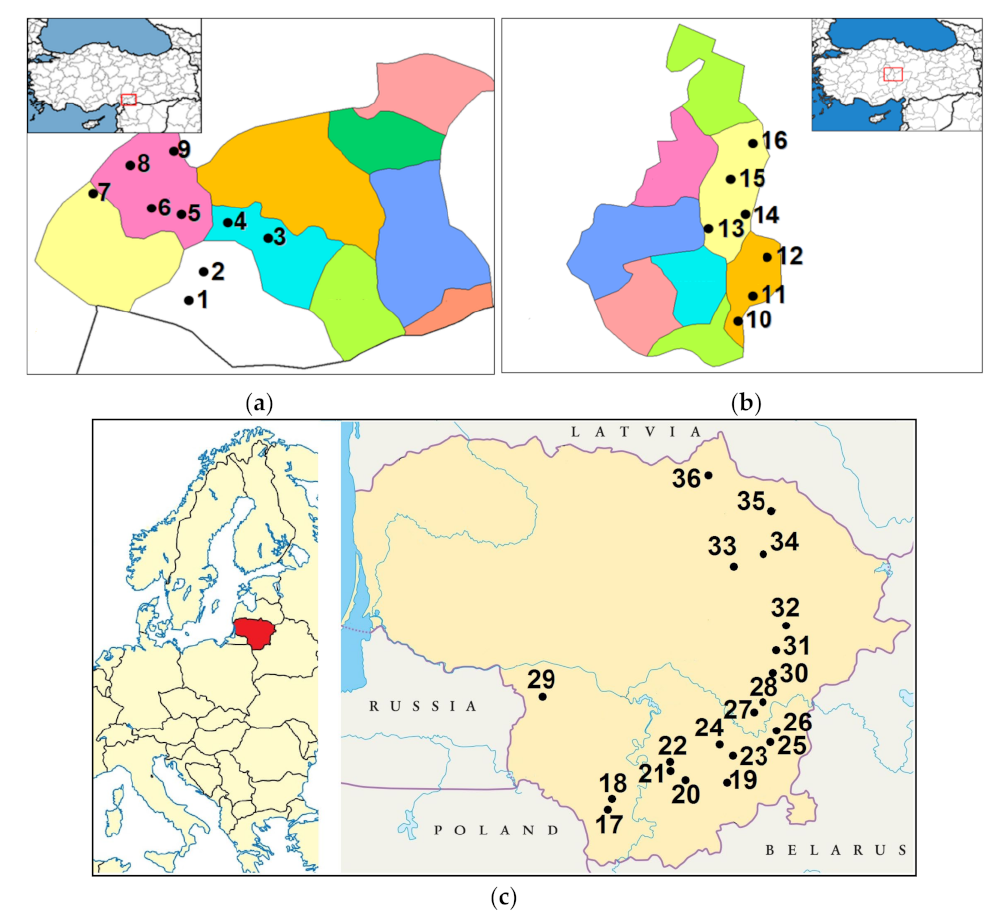
Figure 3. Maps of Achillea millefolium sampling sites in the provinces of Gaziantep ( a ) and Nev¸sehir ( b ) in Turkey and Lithuania ( c